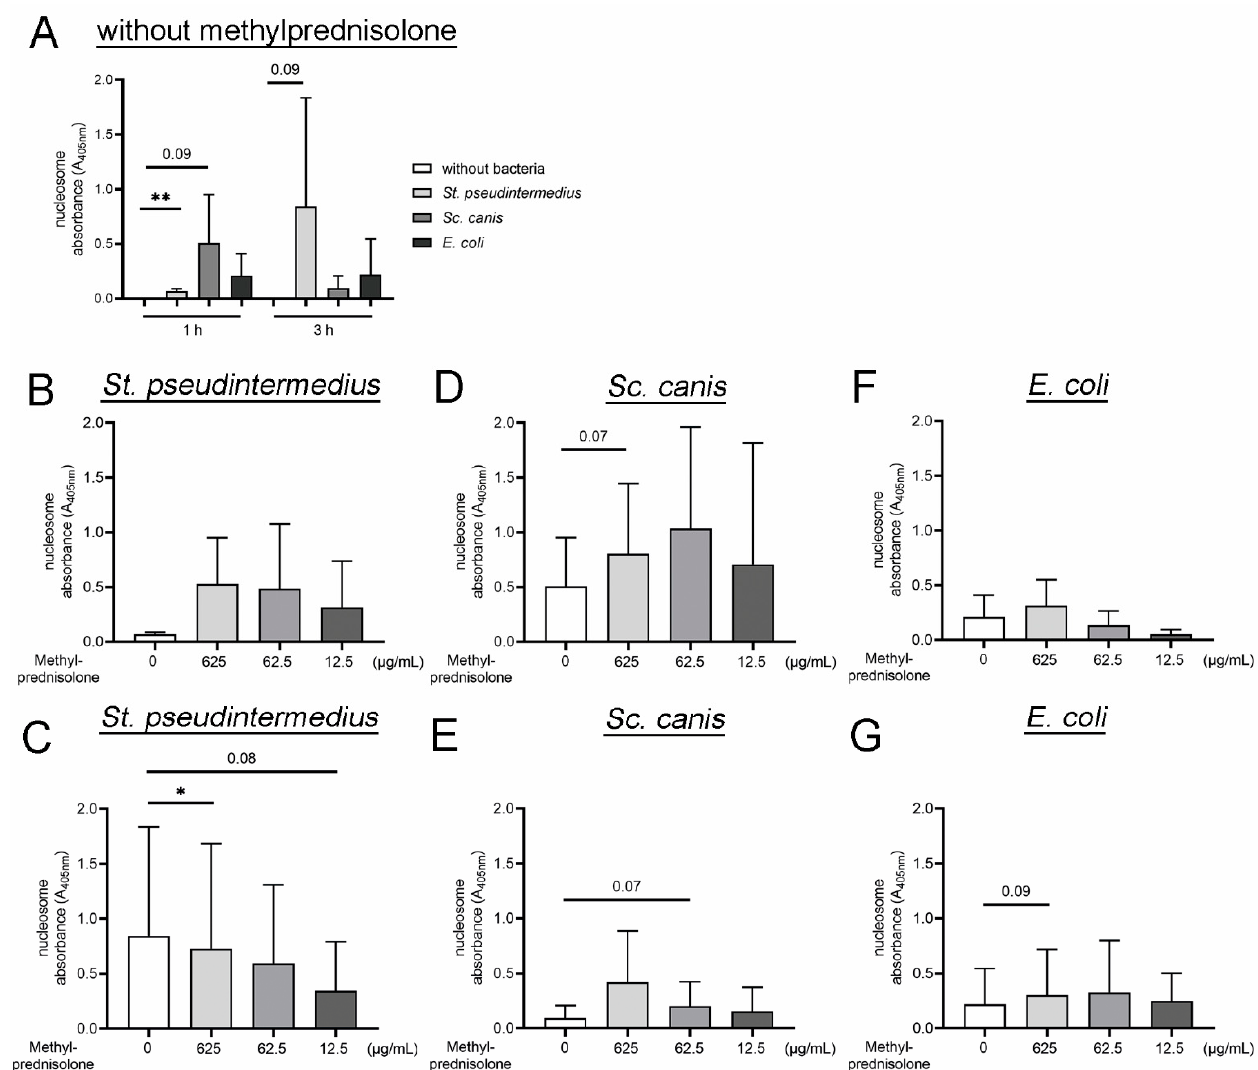
Figure 3. Nucleosomes are released by neutrophils after bacterial infection. The methylprednisolone co-stimulation influ- enced time and concentration dependent on the amount of nucleosomes in the supernatant. The supernatants from bacterial killing assays from Figure 1 were analyzed for nucleosomes. ( A ) Neutrophils incubated without methylprednisolone released nucleosomes into the supernatant after incubation with bacteria. St. pseudintermedius induced the highest release of nucleosomes after 1 h, whereas Sc. canis induced the highest release of nucleosomes after 3 h. ( B , C ) A higher amount of nucleosomes was detected after 1 h of co-incubation from neutrophils with St. pseudintermedius and methylprednisolone. After 3 h, the highest release was detected without co-incubation of methylprednisolone. ( D , E ) A notable higher amount of nucleosomes was measured one and three hours after co-incubation of neutrophils with Sc. canis and 625 µ g/mL of methylprednisolone. ( F , G ) A tendency of higher amounts of nucleosomes was measured one and three hours after co-incubation of neutrophils with E. coli and 625 µ g/mL of methylprednisolone. All graphs show the mean ± SD and statistical differences were detected by one-tailed paired Student’s t -test. The experiments were conducted in independent runs (1 h: n = 3; 3 h: n = 4). Data presented in A are shown partially again in ( B – G ) for statistical analysis in the different infection groups. Statistical results are presented for values lower than 0.1 and higher than 0.05 as Arabic numbers and as the following: *, p < 0.05; **, p <